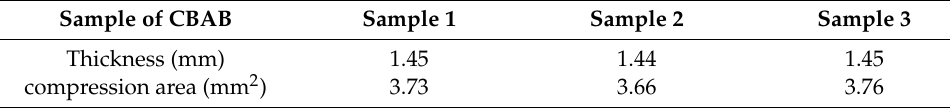
Table 1. CBAB sample parameters.